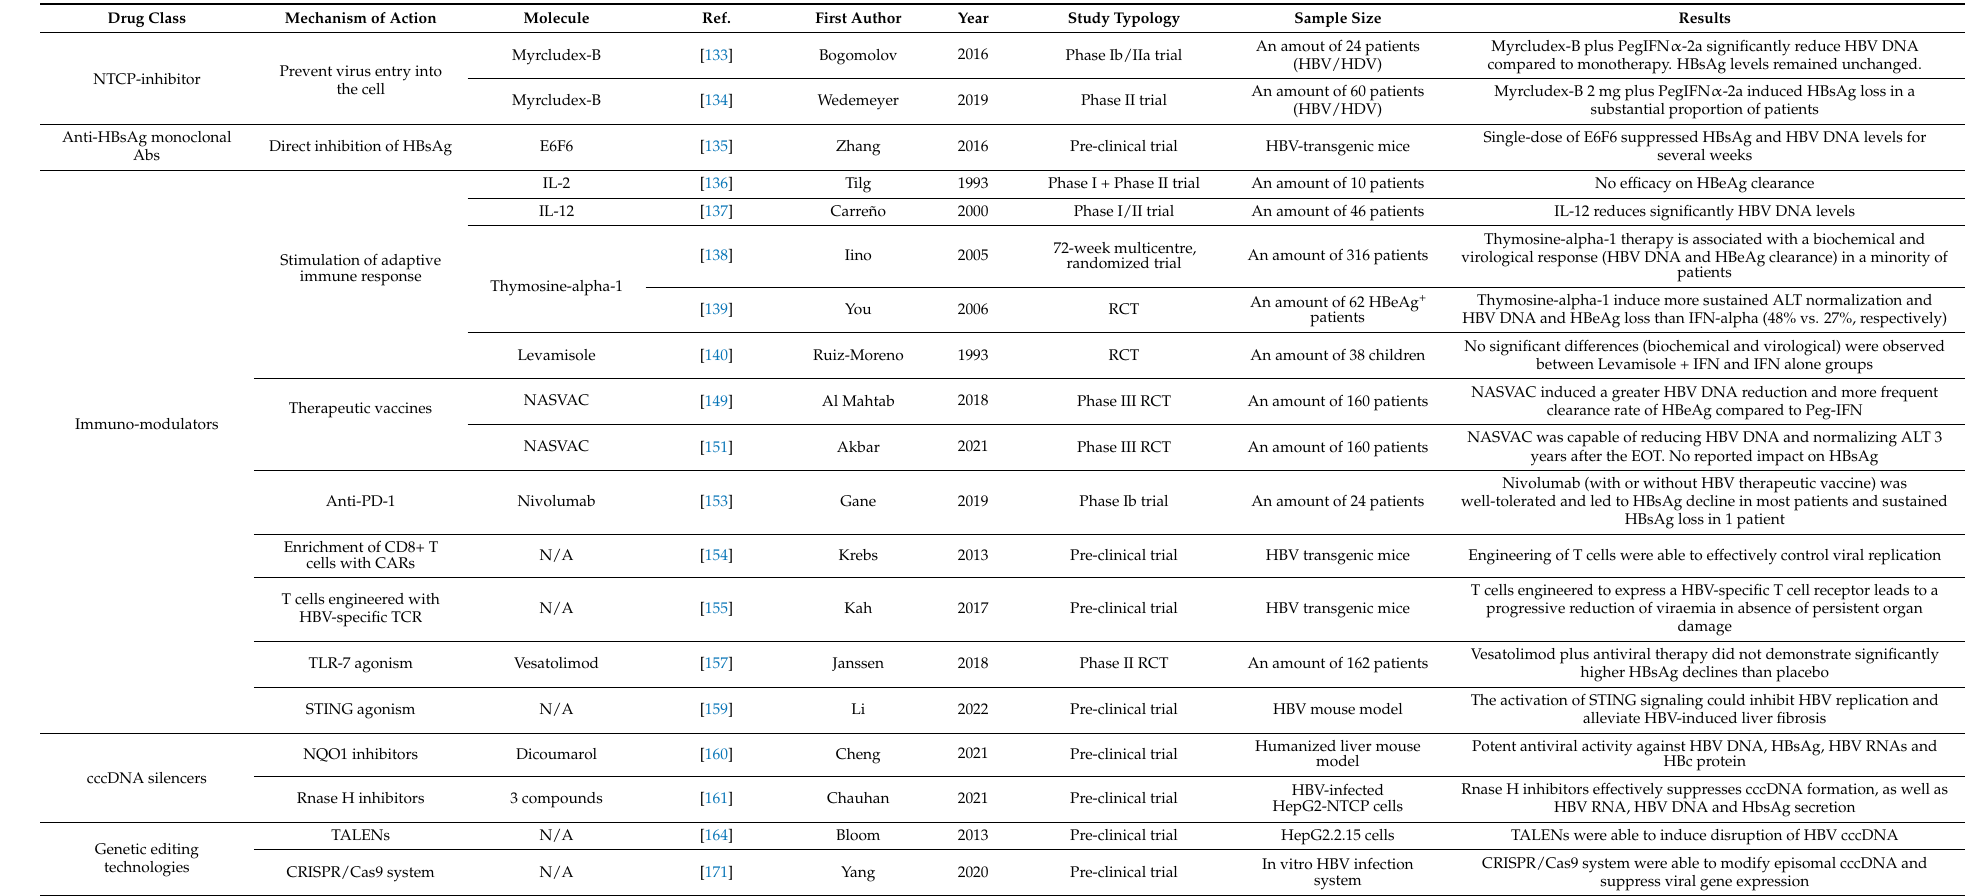
Table 1. Beyond the nucleos(t)ide analogues: a sample of alternative therapeutic strategies for chronic HBV